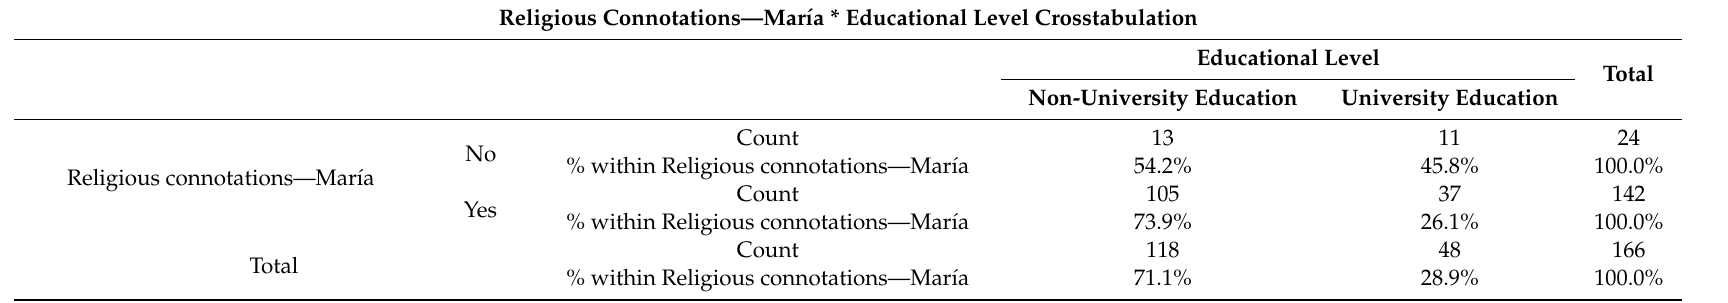
Table 6. Religious connotations in terms of educational level for the name Mar í a in the metropolitan district of Murcia.